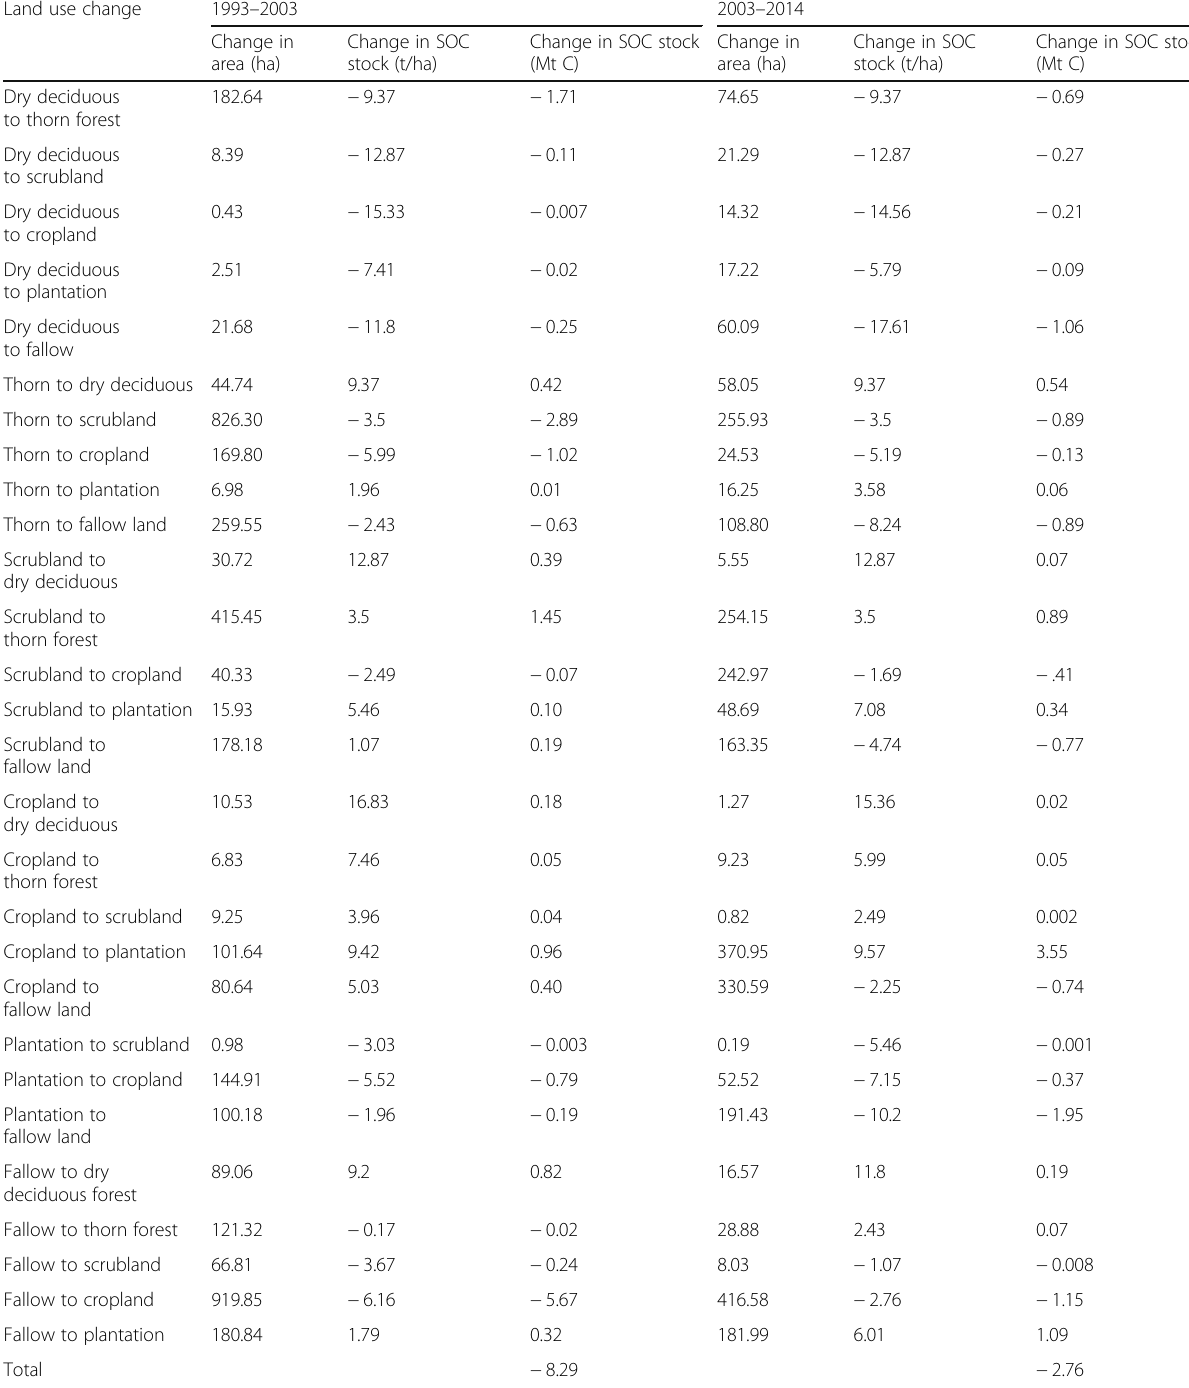
Table 10 Effect of internal trading of land use on SOC stock Land use